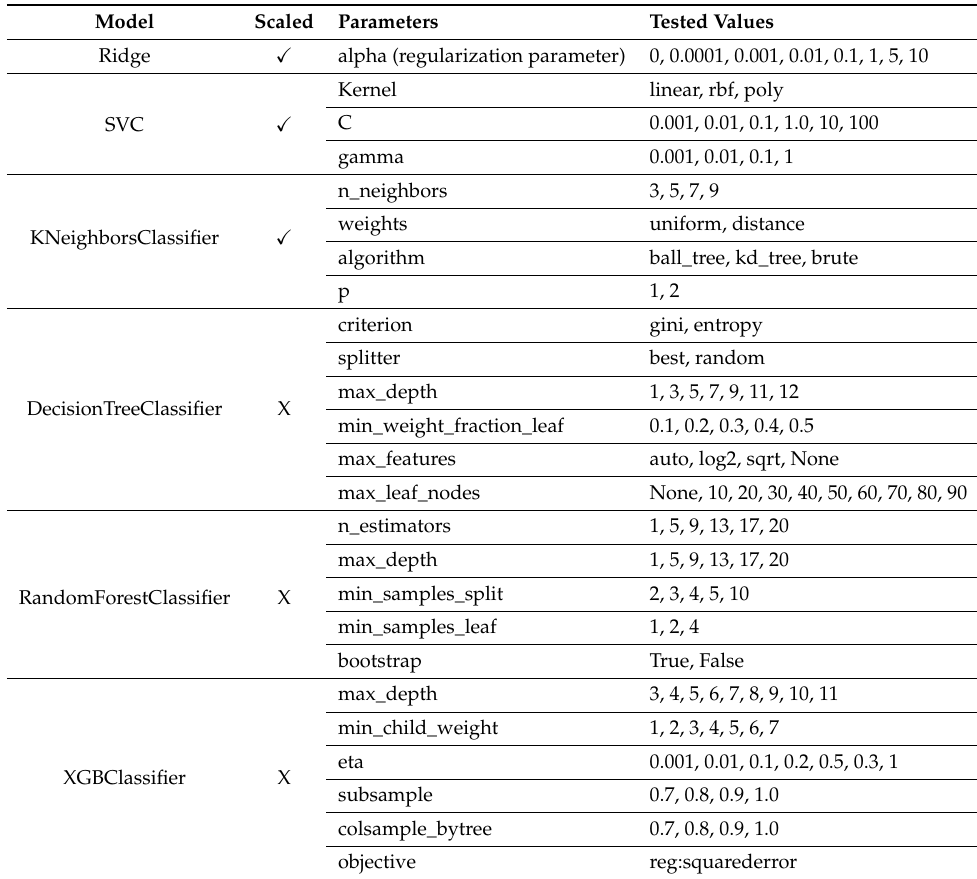
Table 3. ML models and hyperparameters (classification problem). Except for XGBRegressor, Scikit- learn was used to implement all models (https://scikit-learn.org/stable/, accessed on 15 September 2022). Python’s xgboost library was used to implement XGBRegressor. (https://xgboost.readthedocs. io/en/stable/parameter.html, accessed on 15 September 2022). Model Scaled Parameters Tested Values